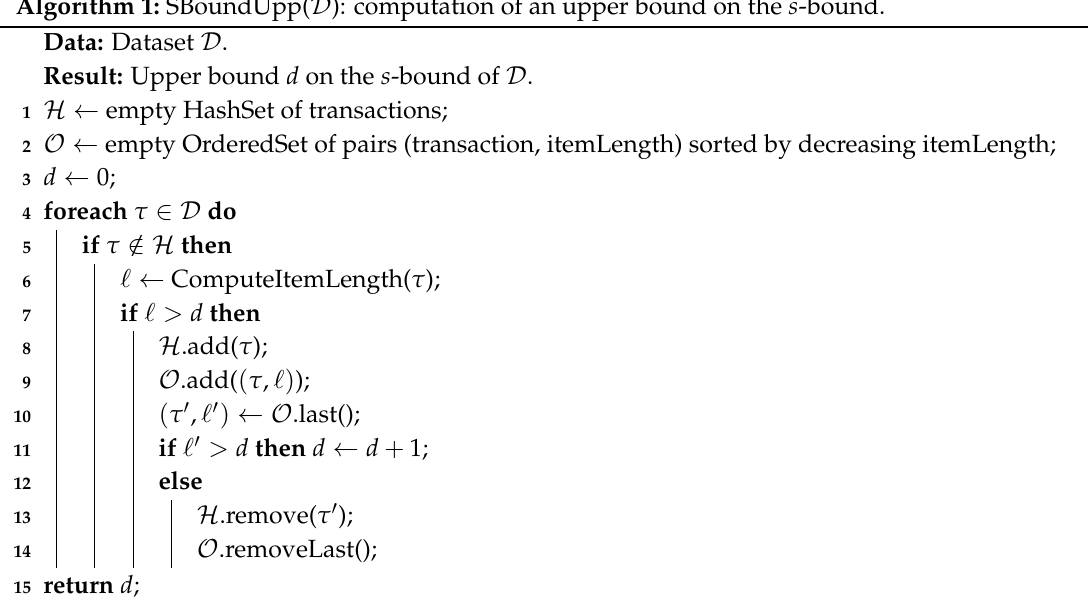
Algorithm 1: SBoundUpp( D ): computation of an upper bound on the s -bound. Data: Dataset D